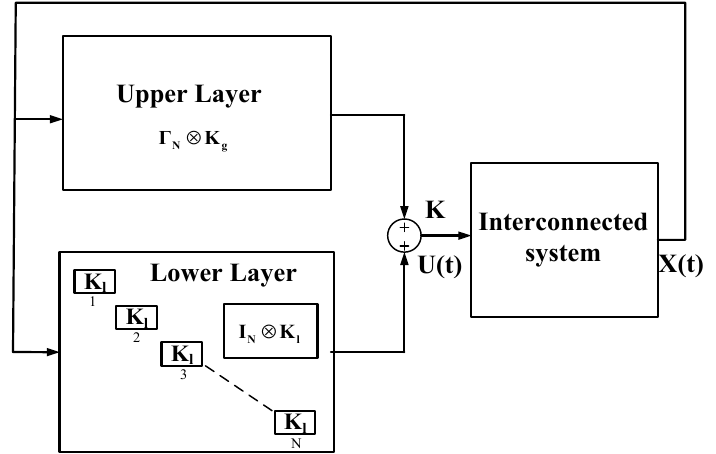
Figure 4. HLQR for a single wheel of the MADD vehicle.